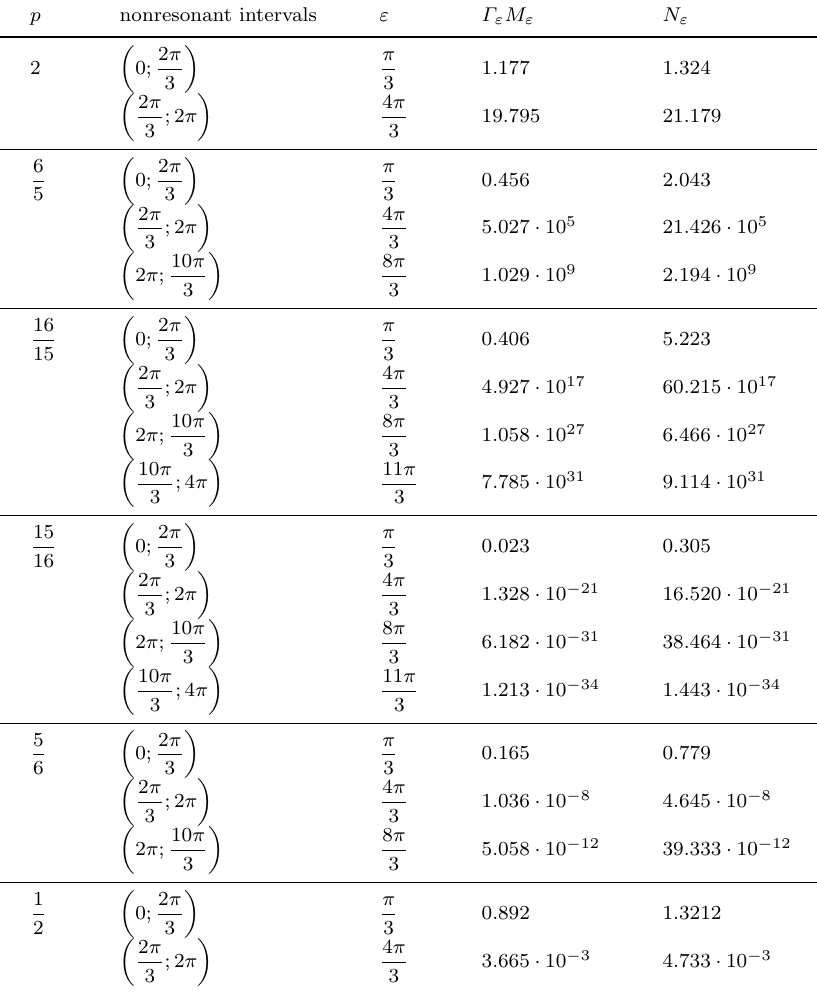
Table 1. Results of calculations for the nonresonant BVP (5.2), (5.3). p nonresonant